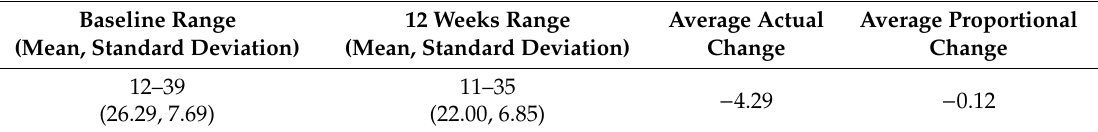
Table 6. QUALID change from baseline to 12 weeks intervention for 31 residents. Score (Lower Score Indicates Better Quality of Life. Minus Figure Indicates Improvement in Quality of